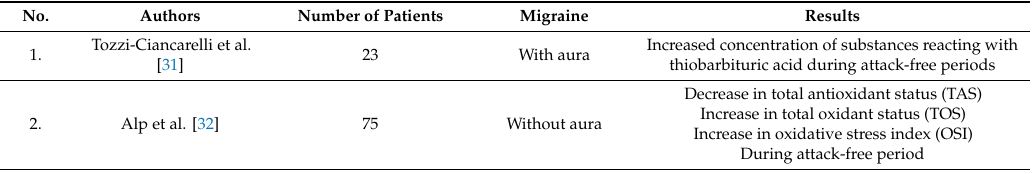
Table 1. Stress and the pathophysiology of